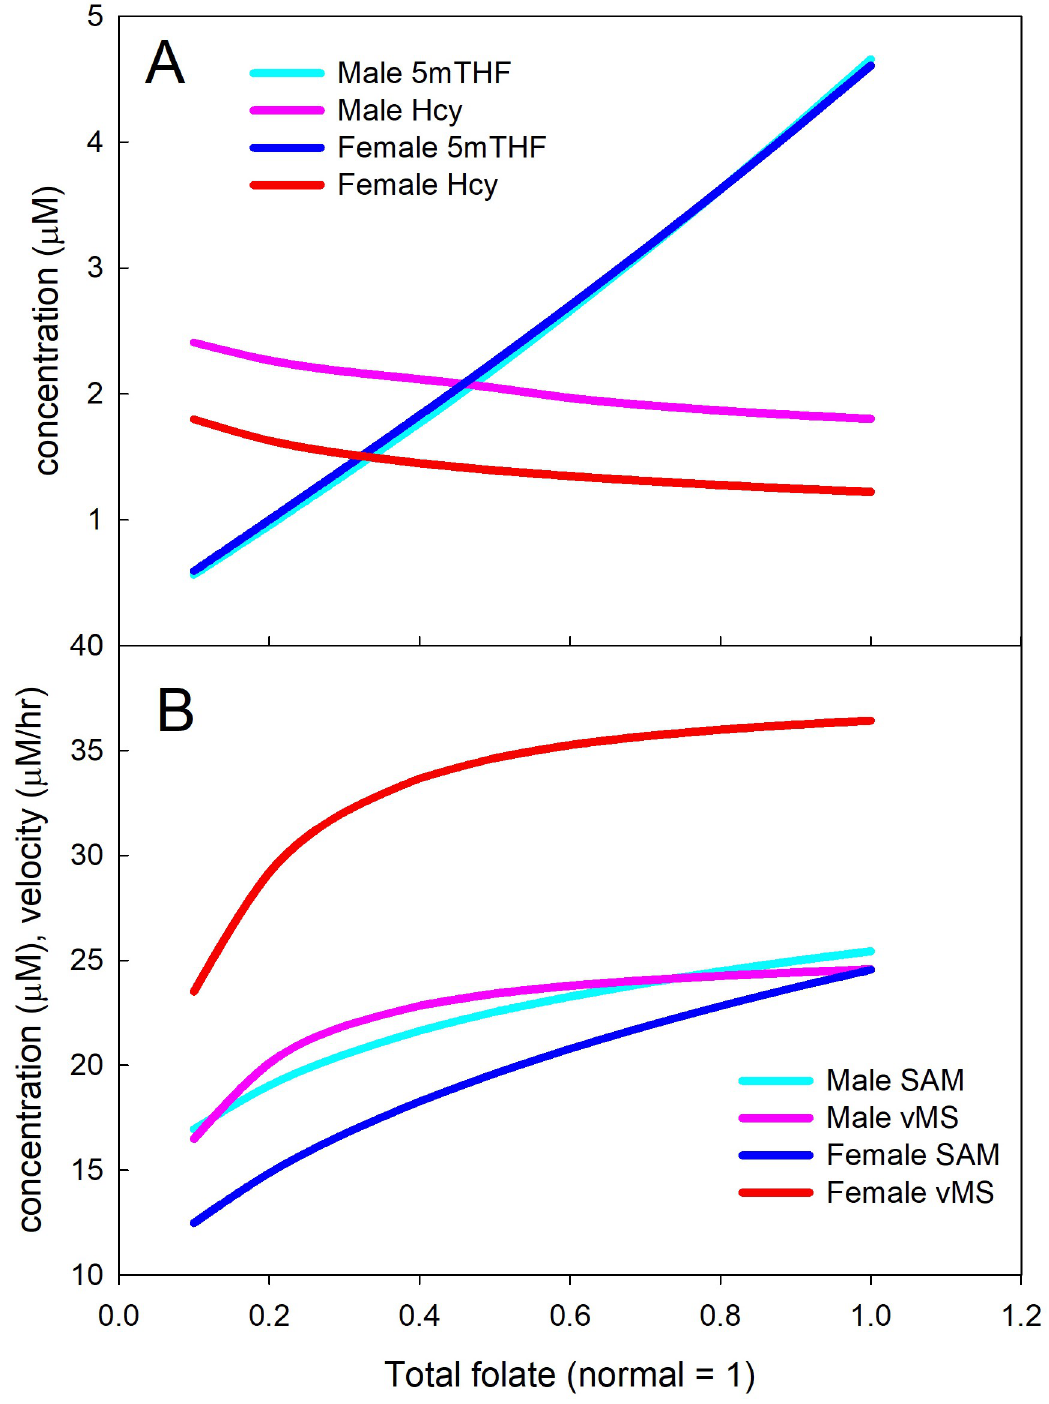
Fig 5. Effects of folate deficiency in the mathematical model. For both males and females, vMS, the velocity of the MS reaction, is homeostatic until total folate gets below 30% of normal. As a result, the Hcy concentration does not depend strongly on total folate. As discussed in [12], the V max of the MS reaction is larger in females than in males, and as usual, the female Hcy concentration is below the male Hcy concentration. Both Hcy curves show the convex shape of the mean curves in the NHANES data in Fig 4a and 4b.